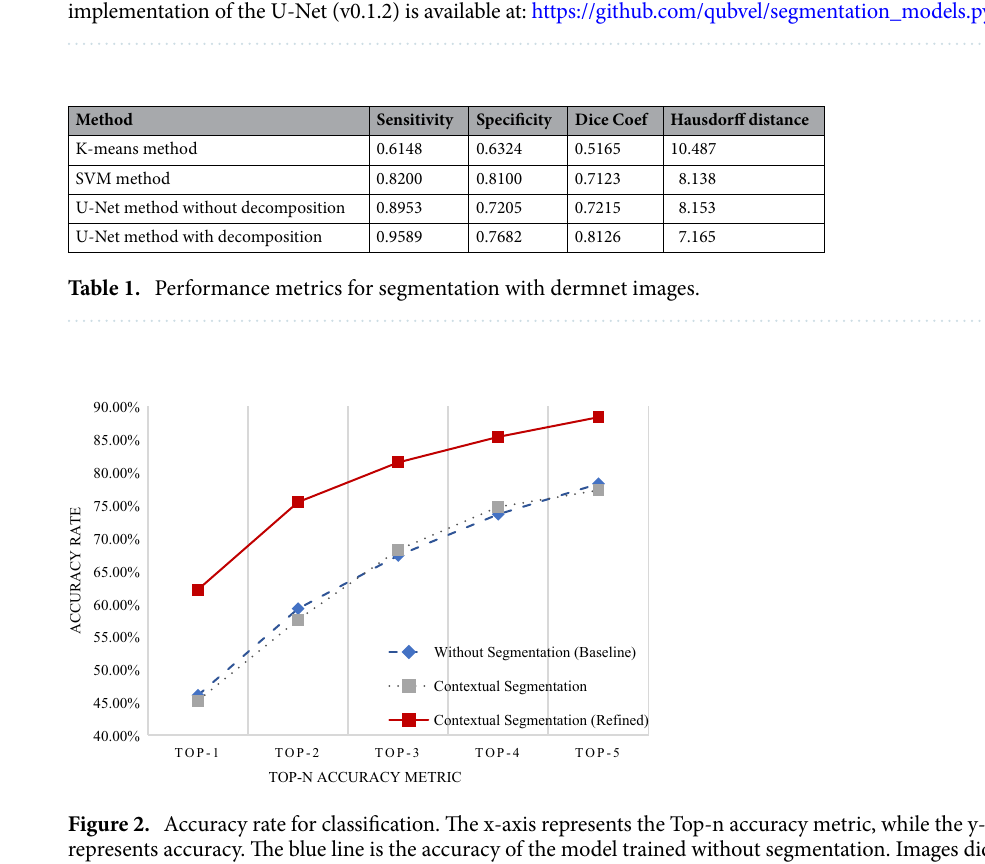
Figure 1. Schematic flow. From left to right, the original is first decomposed into hemoglobin and melanin images. All three images are input to the U-Net which outputs a black-and-white mask image. This mask image is used to draw contours each cluster. A convex hull algorithm is applied to crop each cluster. Each cluster is input to the EfficientNet, which generates a prediction alongside the confidence rate. An open- source implementation of the U-Net (v0.1.2) is available at: https ://githu b.com/qubve l/segme ntati on_model s.pytor ch.